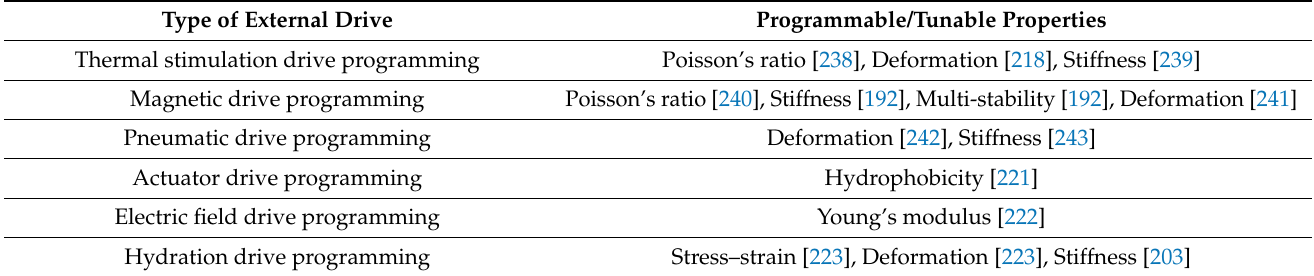
Table 6. Examples of programmable mechanical properties based on external driving